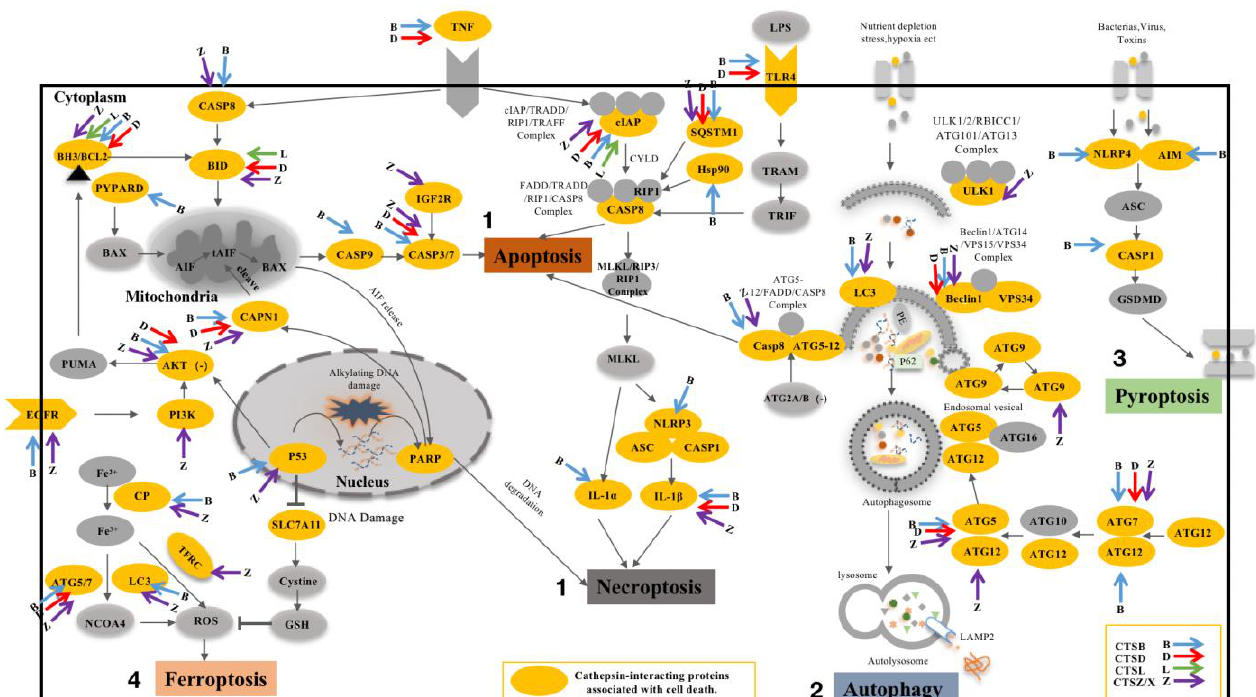
Figure 4. The involvement of CTSB/CTSD/CTSL/CTSZ/X-interacting proteins in cell death. Yellow circles indicate cathepsin-interacting proteins associated with cell death. Blue arrows represent the interacting proteins of CTSB involved in cell death; red arrows represent the interacting proteins of CTSD involved in cell death; green arrows represent the interacting proteins of CTSL involved in cell death; purple arrows represent the interacting proteins of CTSZ/X involved in cell death. 1. The process of apoptosis and necroptosis. 2. The process of autophagy. 3. Pyroptosis process. 4. Ferrop- tosis process.